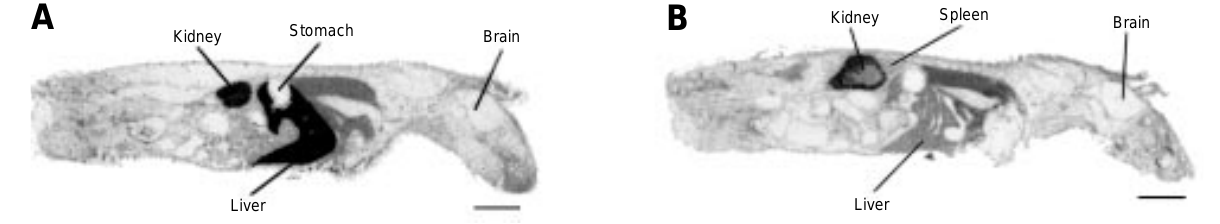
Figure 4 - Whole body radioautographs showing the distribution of total (A) and nonspecific (B) glucagon-binding sites in mice 3 min after intravenous injection of 185 kBq 125 I-glucagon. 125 I-glucagon (3-[ 125 I]iodotyrosyl 10 glucagon dissolved in Ringer solution at a concentration of 185 kBq/0.4 ml) was injected into the tail vein in the absence (A) or presence (B) of excess (25 µg) unlabeled glucagon. Bar = 1 cm.